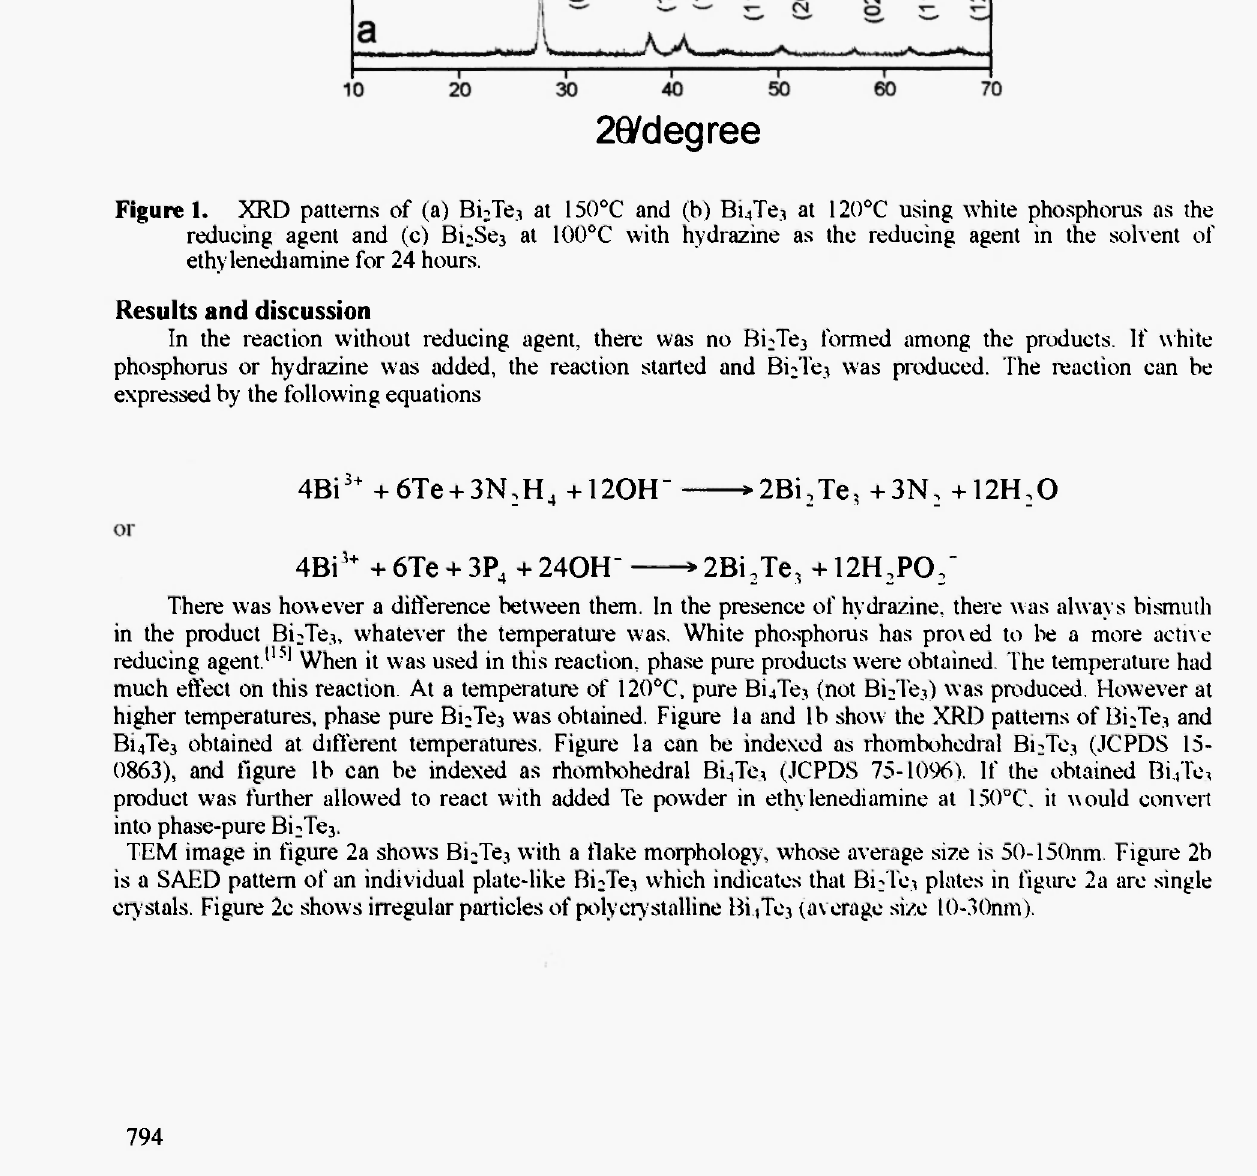
Figure 1. XRD patterns of (a) Bi ; Te 3 at 150°C and (b) Bi 4 Te 3 at 120°C using white phosphorus as the reducing agent and (c) Bi;Se 3 at 100°C with hydrazine as the reducing agent in the solvent of ethylenedjamine for 24